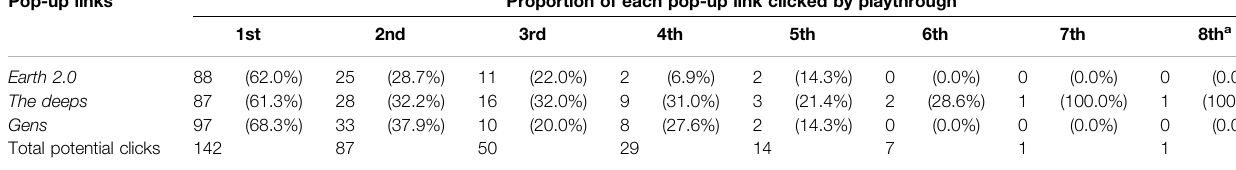
TABLE 7 | Pop-up links clicked by playthrough. Pop-up links Proportion of each pop-up link clicked by